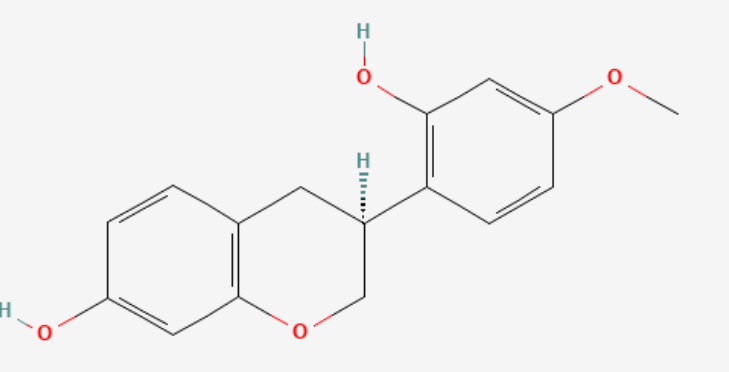
Figure 5. Chemical structure of (3 S )-vestitol, isolated from Brazilian red propolis. (Figure obtained from